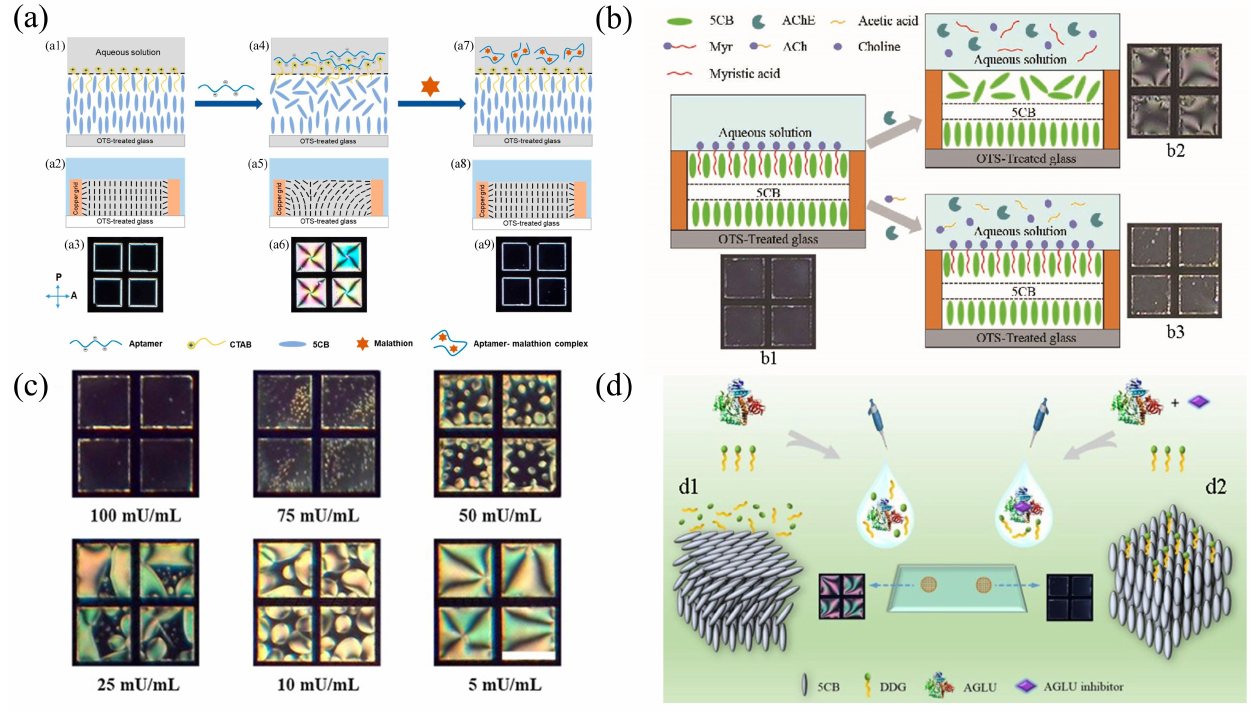
Figure 4. ( a ) Schematic of LC sensor device for malathion detection [97]; copyright with